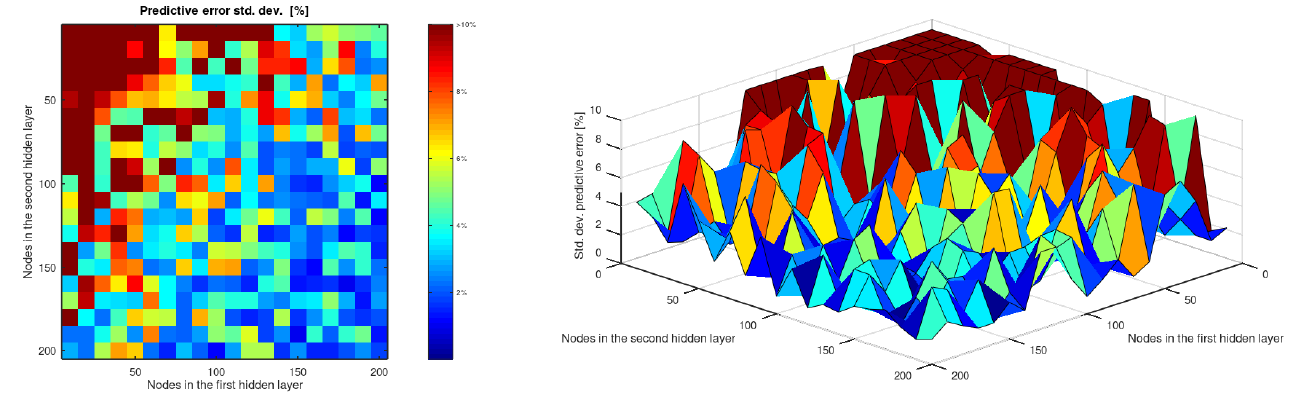
Figure 5. Standard deviation of the predictive error [%] (trimmed above